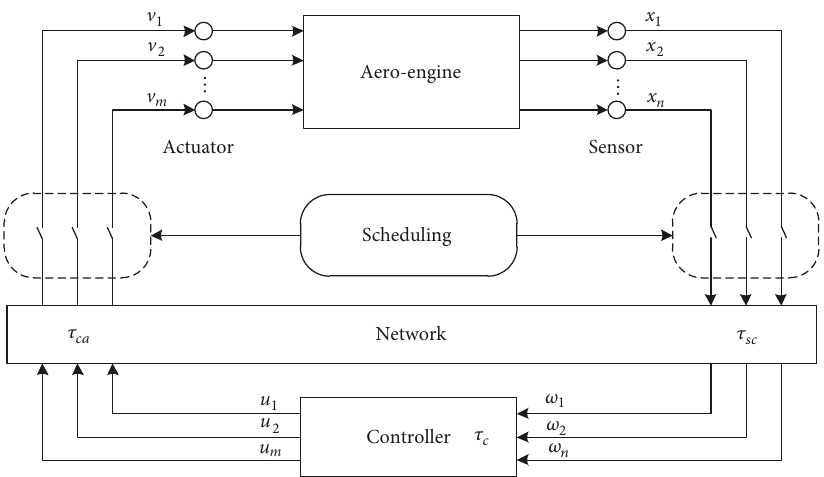
Figure 1: Structure of aeroengine networked control systems with resource